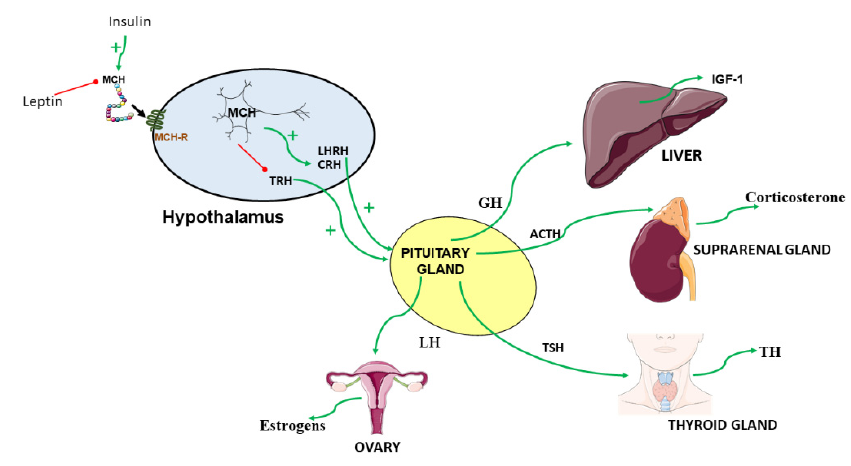
Figure 1. A description of the crosstalk between the MCH and endocrine factors. Abbreviations used: ACTH—adrenocorticotropic hormone; CRH—corticotrophin-releasing factor; GH—growth hormone; IGF-1—insulin growth factor 1; LH—luteinizing hormone; LHRH—luteinizing hormone releasing hormone; MCH—melanin concentrating hormone; MCH-R—melanin-concentrating hor- mone receptor; TH—Thyroid hormone; TRH—thyroid releasing hormone; TSH—thyroid stimulat-